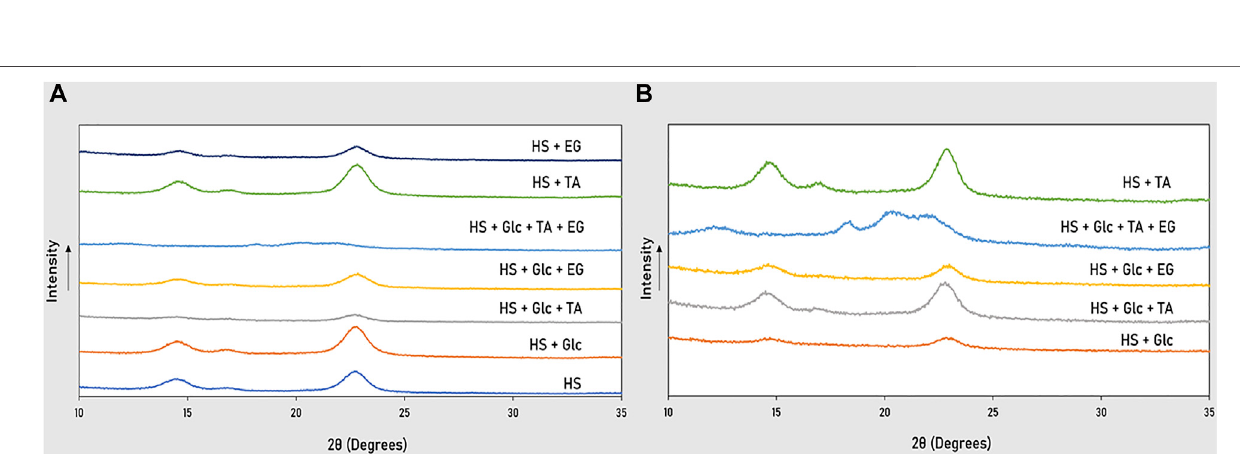
Frontiers in Bioengineering and Biotechnology |